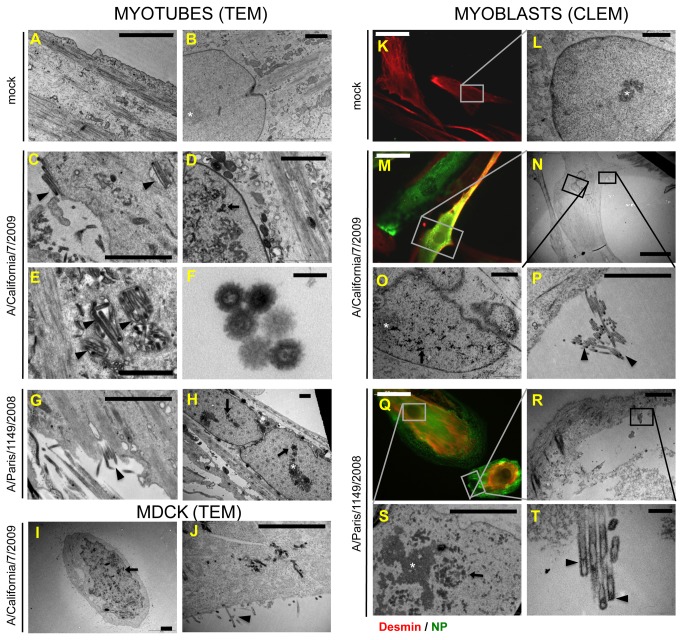
Virus budding from infected myotubes and myoblasts.
A to J. Transmission electron microscopy (TEM) was performed on non-infected myotubes (A, B), on myotubes infected for 20h with the A/California/7/2009 (C, D, E, F) or the Paris/1149/2008 (G, H) isolates, and on MDCK-SIAT cells, 16h after infection with the A/California/7/2009 isolate (I, J). Arrowheads: budding virions or virions in close contact with the cell. Arrows: dense nuclear aggregates. Stars: nucleoli. Bars: A to E and G to J: 2µm; F: 100nm.
K to T. Correlative light and electron microscopy (CLEM) was carried out on non-infected myoblasts (K, L) and on myoblasts infected for 20h with the A/California/7/2009 (M, N, O, P) or the A/Paris/1149/2008 (Q, R, S, T) isolates. K, M, Q. Immunofluorescence imaging of myoblasts expressing desmin (red) and/or NP (green). L. Transmission electron microscopy imaging of a non-infected myoblast observed in K showing an intact nucleus. N, O, P and R, S, T. Transmission electron microscopy imaging of the cells observed in M and Q, respectively, showing budding virions or nuclear aggregates. Arrowheads: budding virions or virions in close contact with the cell. Arrows: dense nuclear aggregates. Stars: nucleoli. Bars: K, M, Q: 50µm; N, R: 20 µm; L, O, P, S: 2µm; T: 200nm.